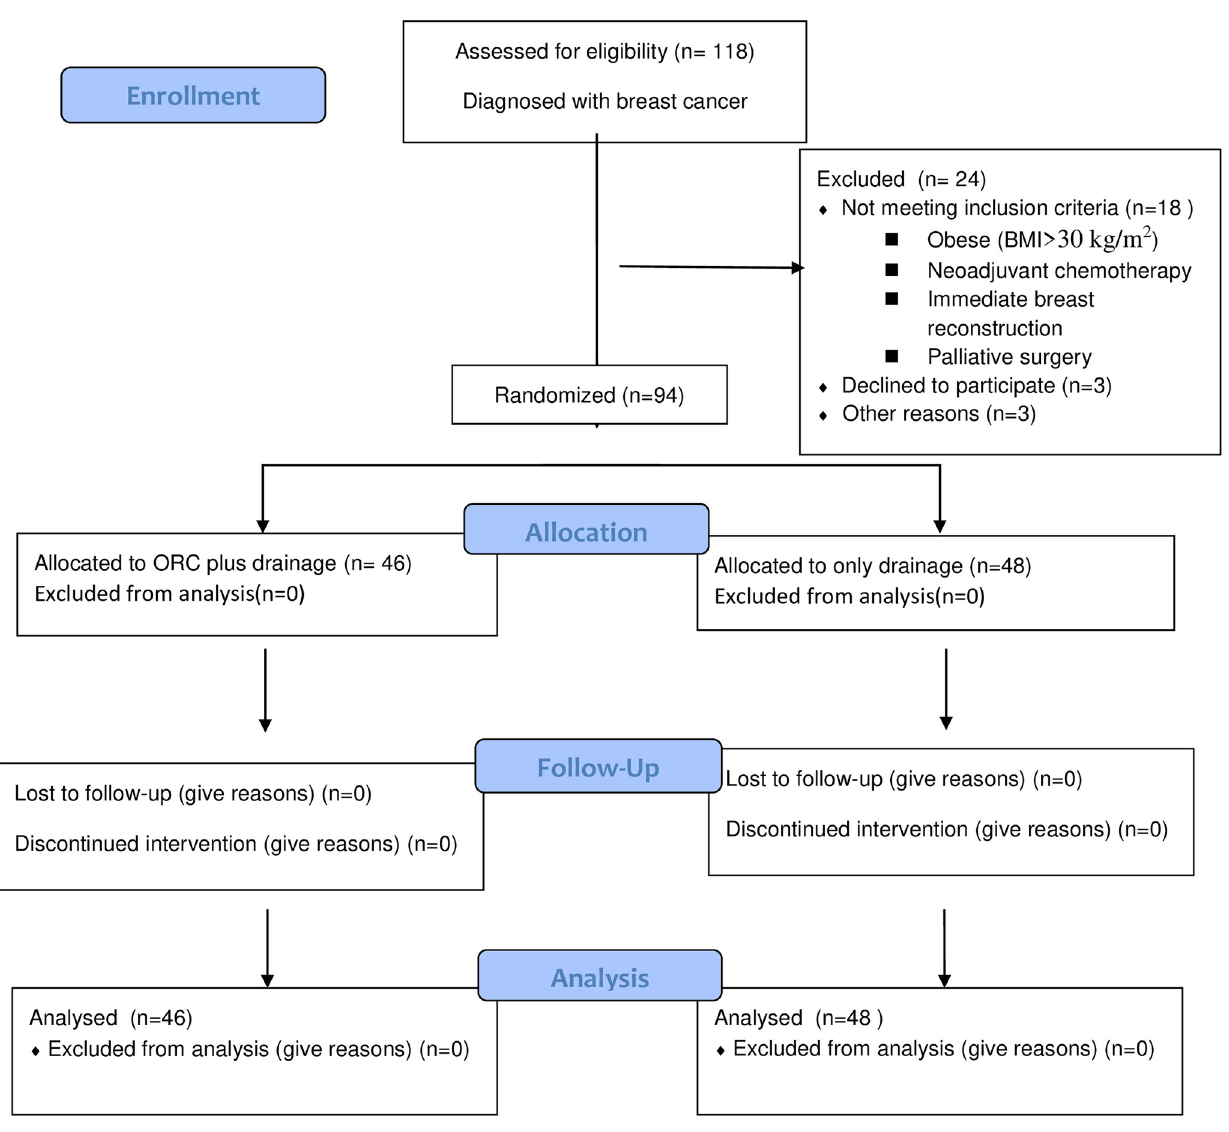
Fig 1. CONSORT flow diagram for present